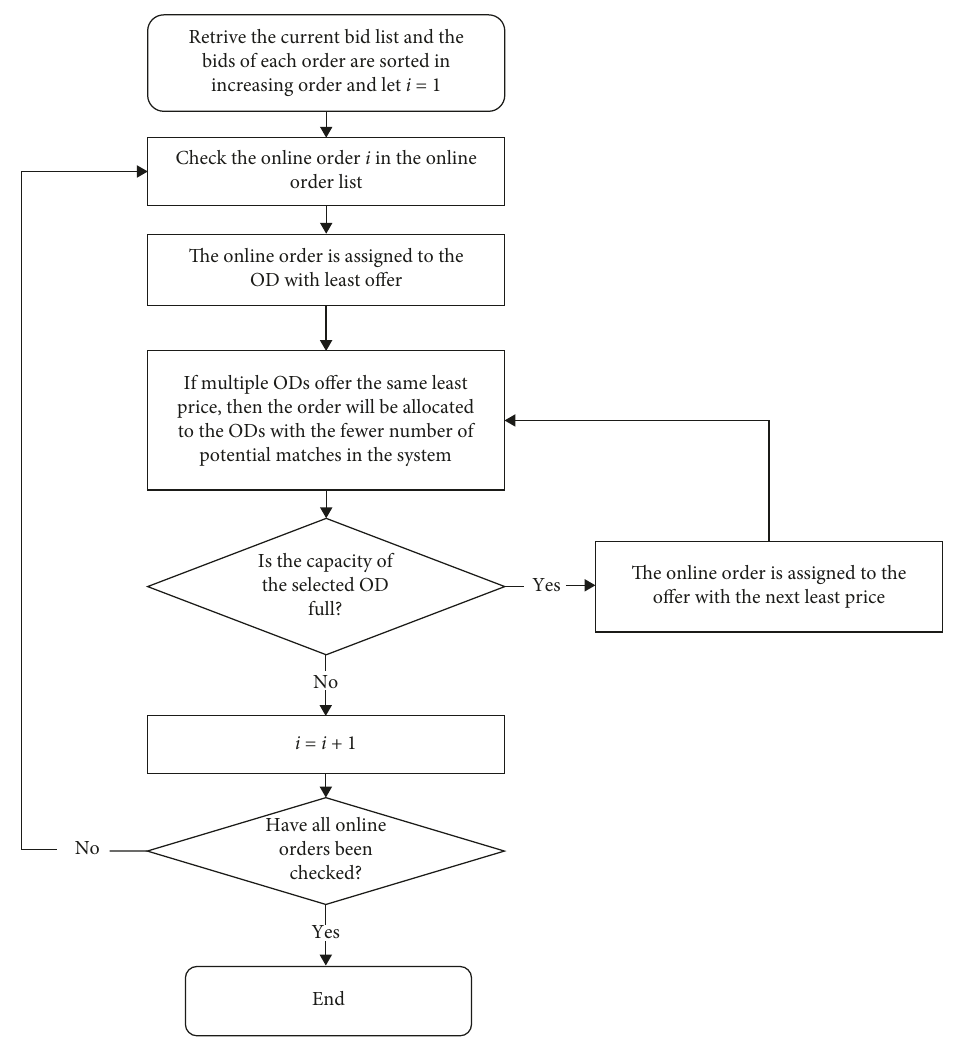
Figure 5: Auction-based matching